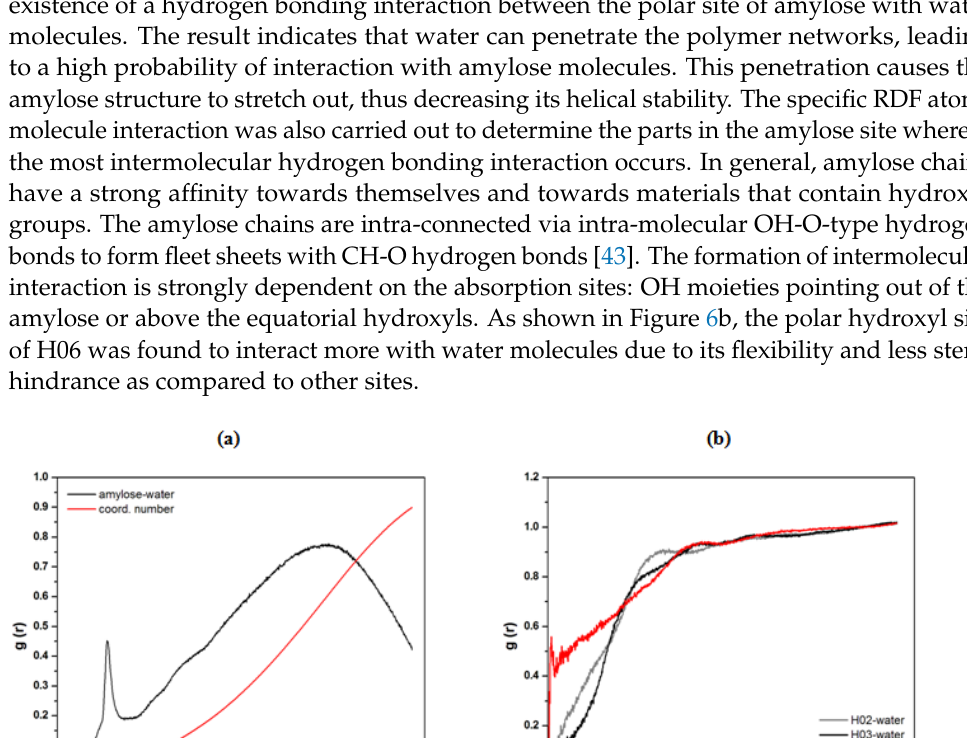
( b ) Figure 7. Density maps (number of molecules/nm 3 ) showing ( a ) water molecule distributions and ( b ) amylose at P = 1.0 bar and T = 198.15 K (in the interlayer at d = 001 spacing) for the amylose–H 2 O system. The results were obtained by averaging over 2.0 ns of simulation time. 3.3. Physiochemical Properties of S-SAP The physicochemical properties S-SAP were studied using the FESEM, EDX, XRD and DSC analyses, as presented in Figure 8. Based on the micrograph shown in Figure 8a, it was observed that the morphology of S-SAP displayed continuous agglomeration of loose particles of homogeneous S-SAP. Based on the loose structure, it can be noted that the foaming process of the starch slurry assists in improving the SAP’s absorption charac- teristics. This finding is also in a good agreement with those reported by Saha et al. (2020)